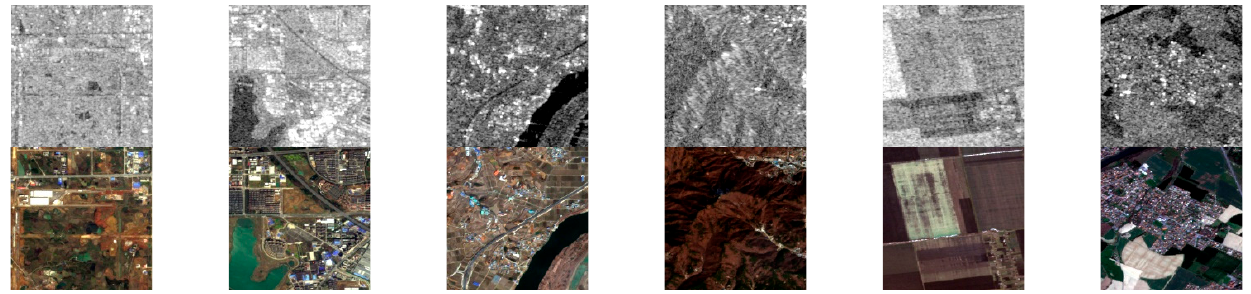
Figure 5. Some examples of training data. First row: SAR image blocks. Second row: optical image blocks.